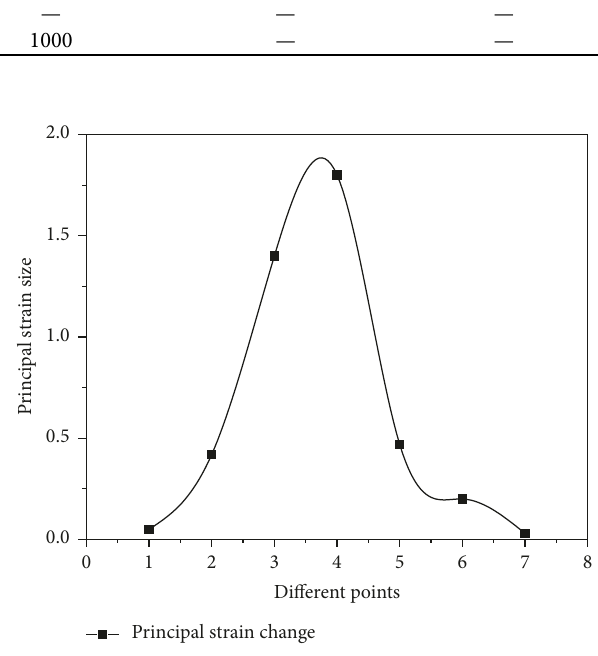
Figure 3: Cloud map of principal strain distribution at different drawing